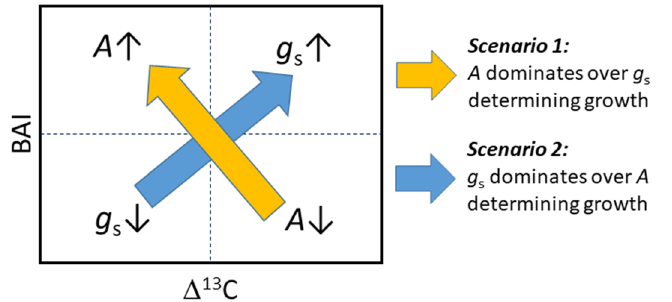
Figure 6. Mechanistic interpretation of the association between growth (basal area increment, BAI) and carbon isotope discrimination ( ∆ 13 C ), as dominated by changes in either net assimilation ( A ) or stomatal conductance ( g s ). stomatal conductance ( g s